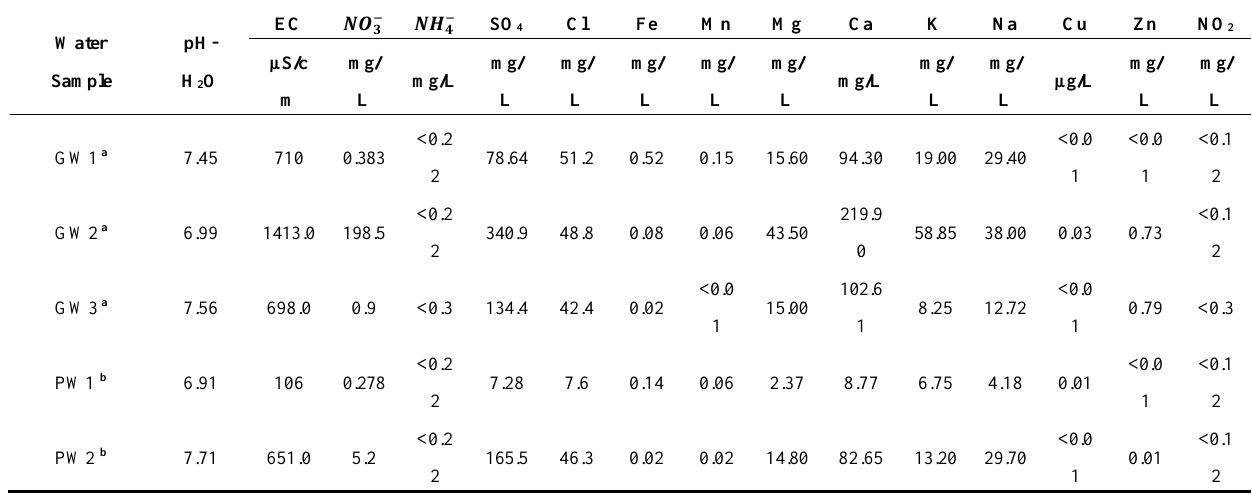
Table 2. Chemical water characteristics of the five irrigation water